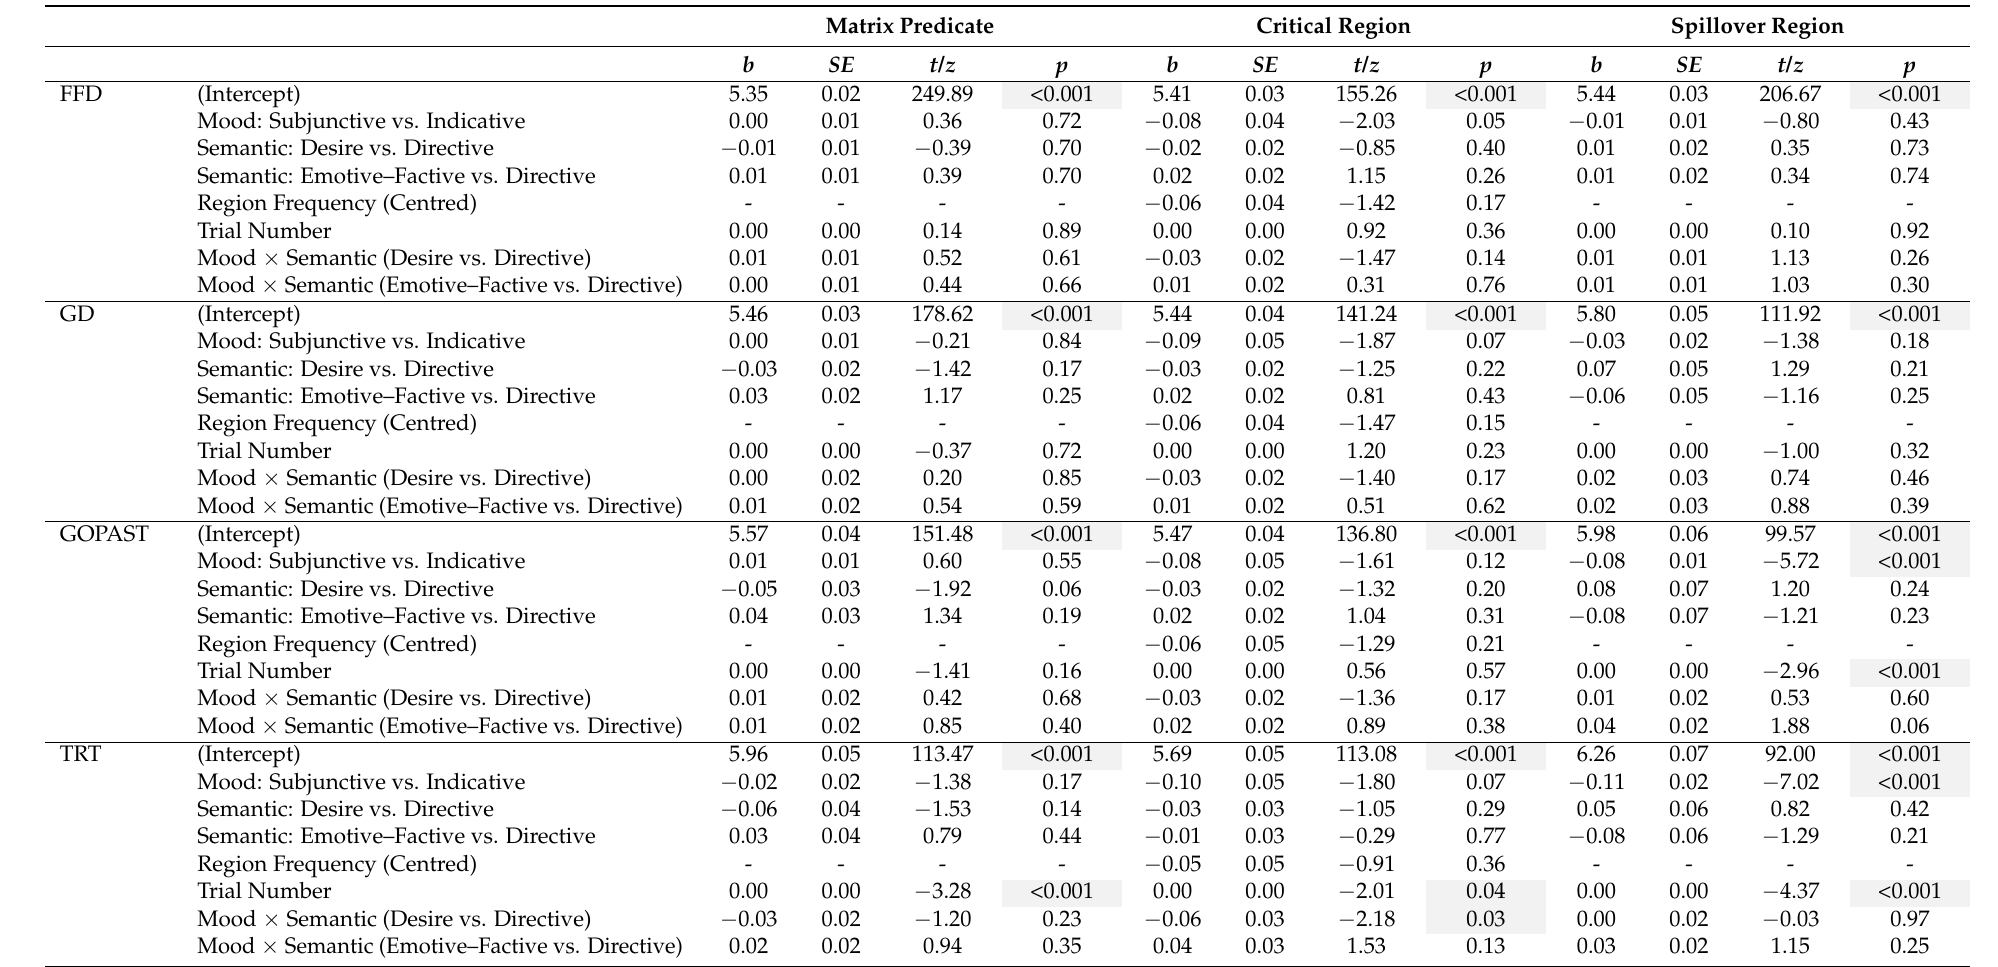
Table A5. Estimates from mixed-effects models for L1 eye movement